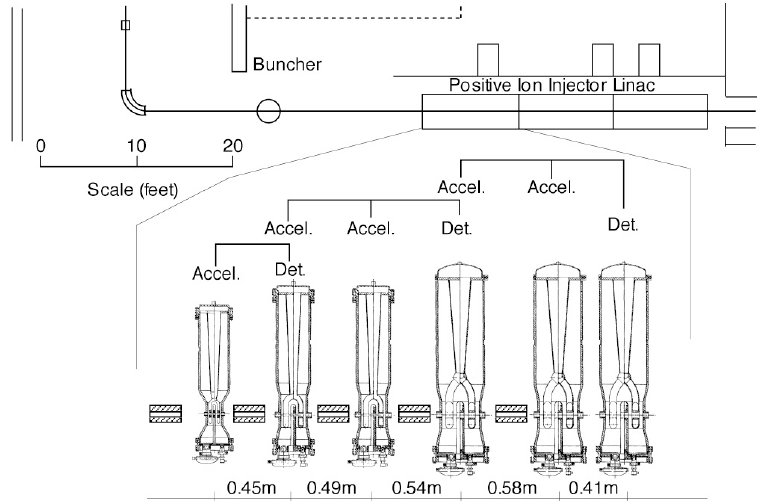
FIG. 9. Floor plan of the ATLAS Positive Ion Injector and a blowup of the resonator configuration in the first cryostat used to develop the techniques described in this paper.